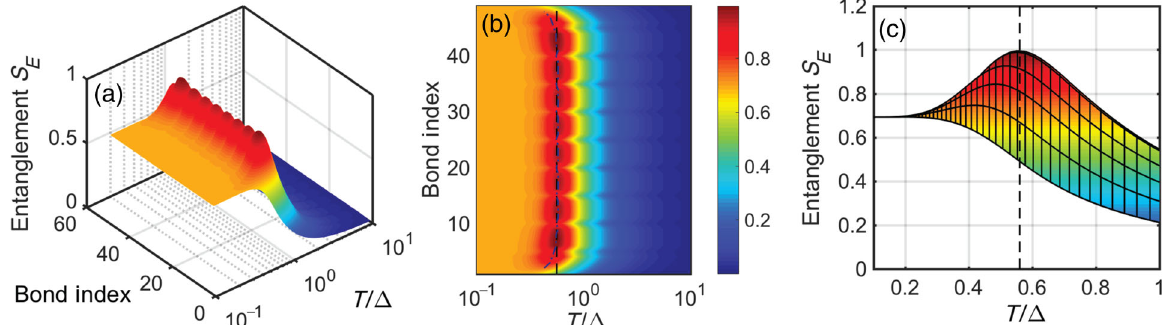
19. (a) Block entanglement landscapes versus temperature T= Δ and bond index for the XXZ model on a square lattice (using Δ ¼ 5 , L ¼ 10 , W ¼ 5 keeping up to D ¼ 500 states, i.e., similar analysis as in Fig. 13 but for a smaller system size). (b) Top view and (c) side view versus T= Δ of the same data as in (a). The black dashed line represents the exact value T c ¼ 0 . 56 , and the dash-dotted line is tracking the “ ridge ” of entanglement landscape (i.e., maxima versus T on each bond) in (a); the latter coincides with T c in the central bonds of the system. Incidentally, the envelope of entanglement curves also shows a peak around T c (with the resolution δ T= Δ ≃ 0 . 02